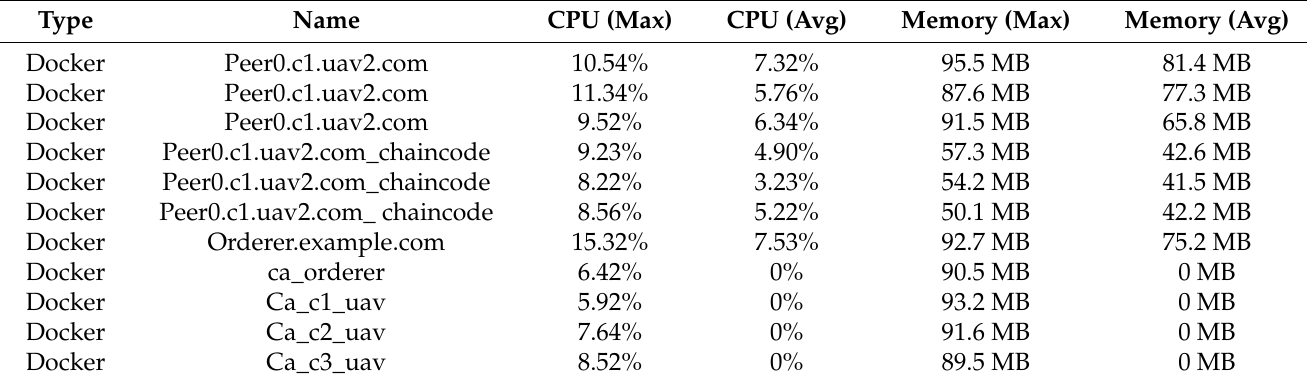
Table 4. Resource utilization analysis of the proposed